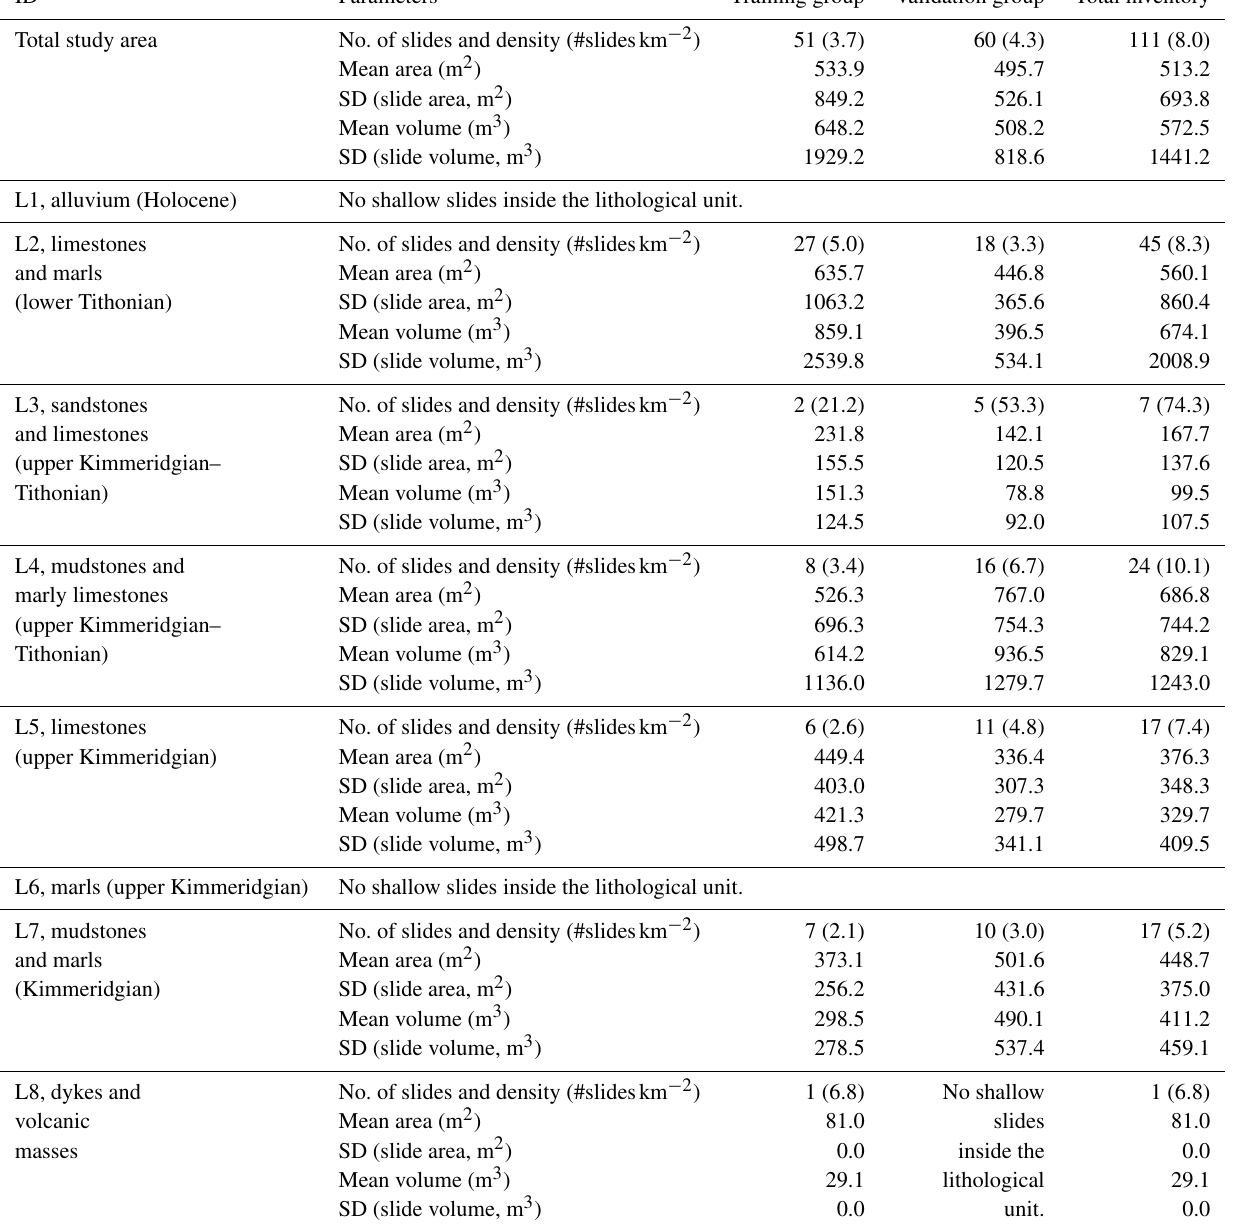
Table 1. Shallow slides inventory characteristics and distribution per lithological unit. Landslides affecting more than one lithological unit were considered within the dominant lithological